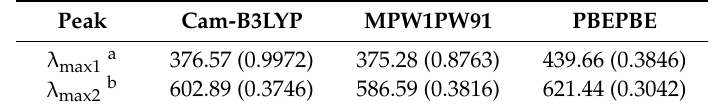
Table 2. Calculated absorption peaks and corresponding oscillator strengths (in bracket) of chlorophyll via TD-DFT method with different functionals at